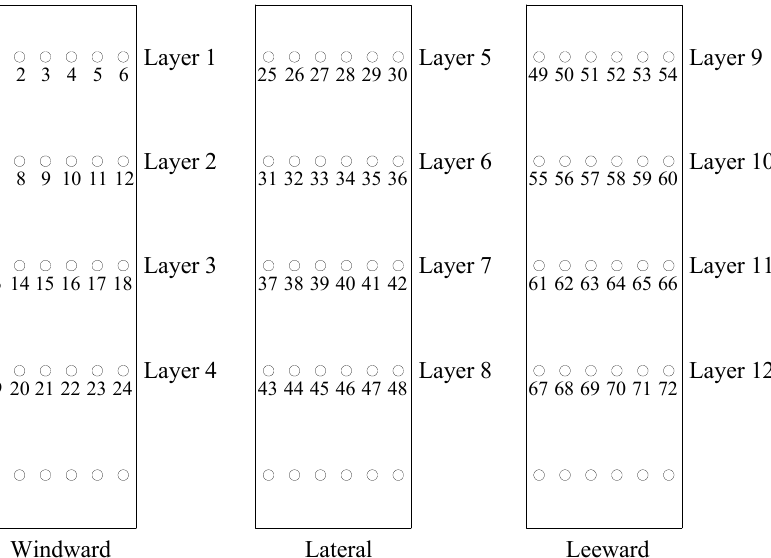
Figure 3. The layout of the pressure points of the model.